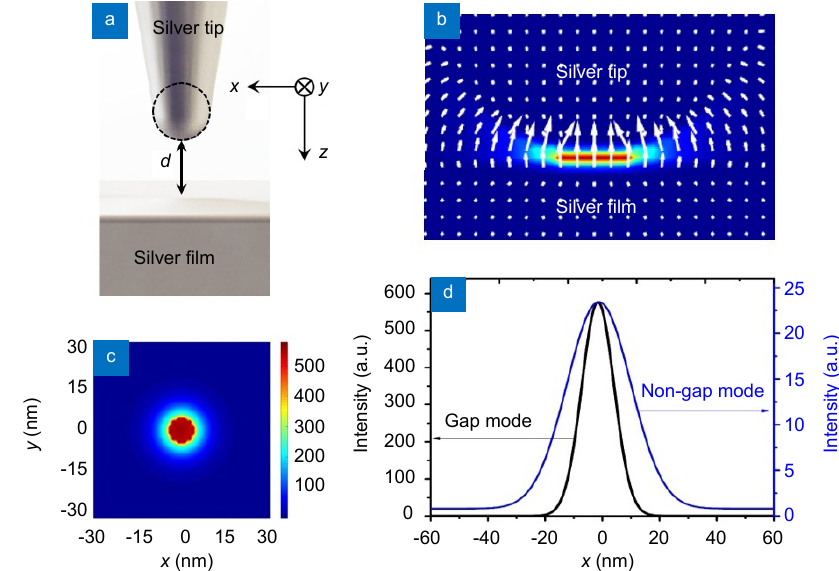
Fig. 6 | ( a ) Gap-mode configuration with the gap distance d =2 nm. ( b ) Electric field intensity and polarization distributions in the x-z plane. ( c ) Electric field intensity distribution in the x-y plane at 1 nm below the tip apex. ( d ) Comparison of electric field enhancement factor between the non-gap mode (Fig. 4(i)) and gap mode located at 1 nm below the apex of the silver